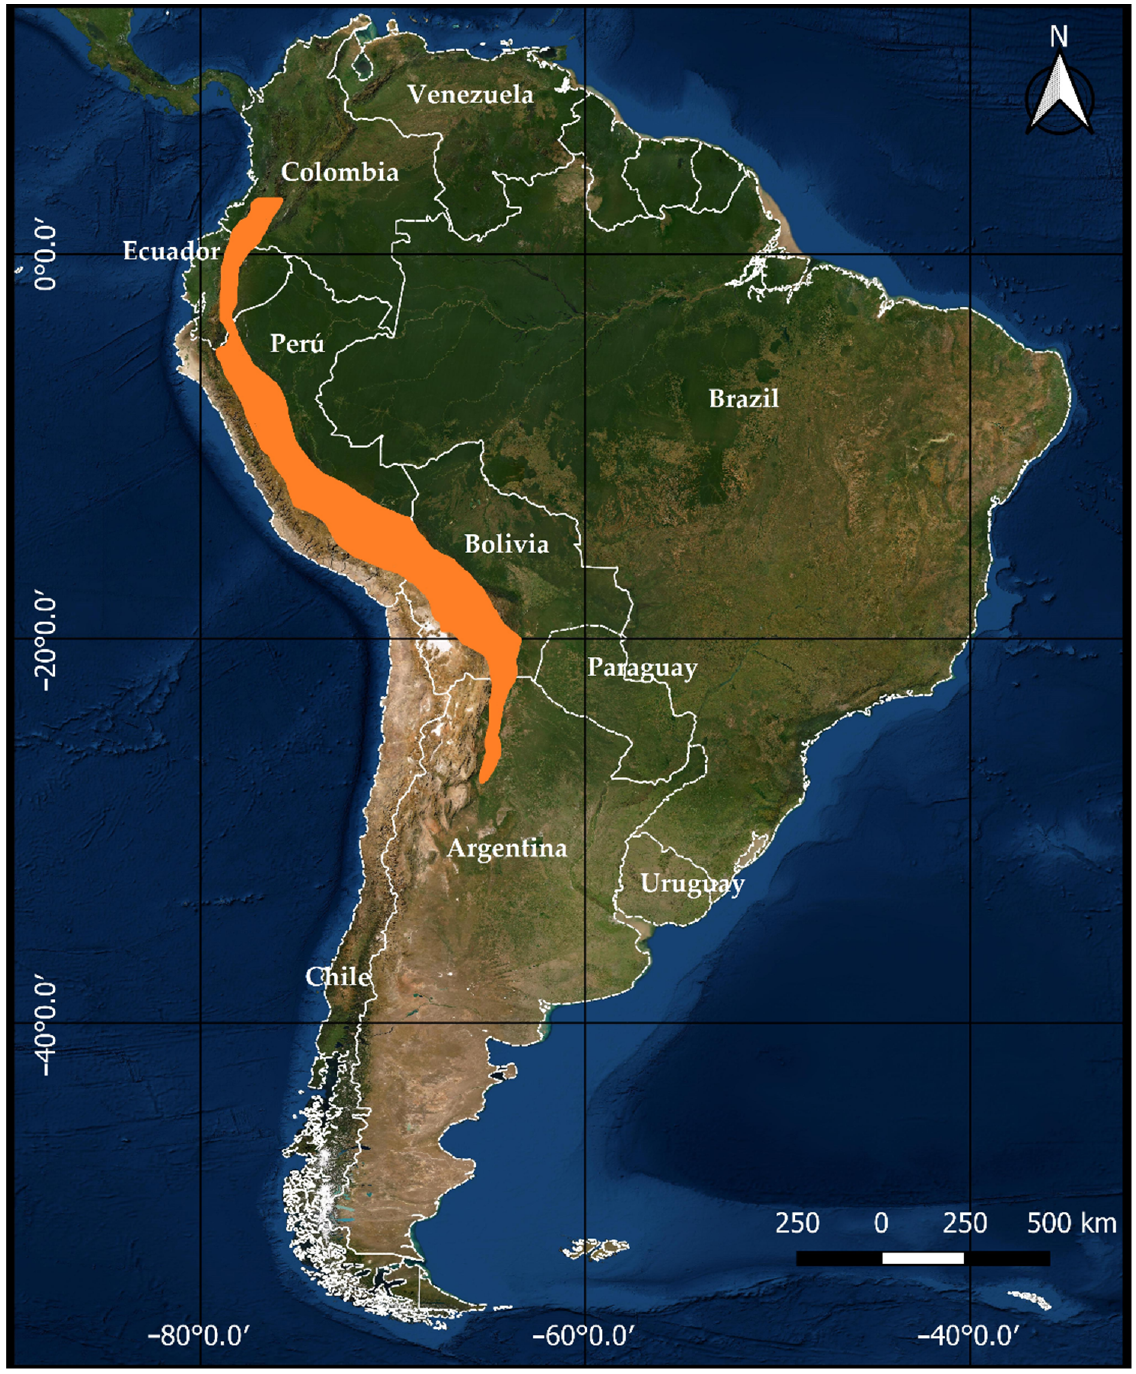
Figure 1. Geographic distribution of S. betaceum in South America. The orange section indicates the places of distribution. The map was made by the authors.